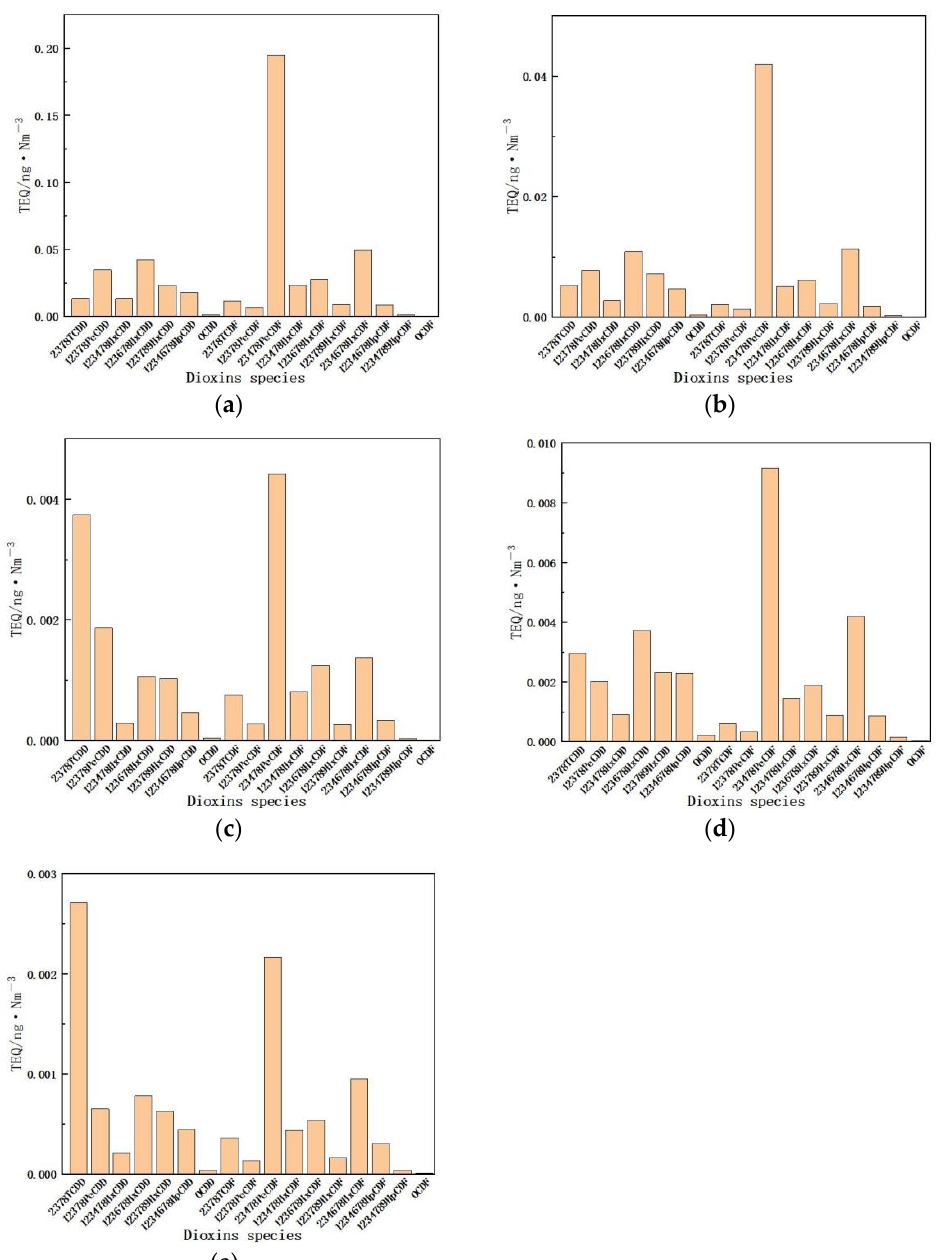
Figure 3. A total of 17 PCDD/Fs TEQ in fly ash: first baghouse without activated carbon injection, first baghouse with activated carbon injection and second baghouse with activated carbon injection. Based on the analysis of dioxins in fly ash, sampling and analysis of dioxins in gas samples were carried out at five points: inlet of the first baghouse, inlet and outlet of the second baghouse with and without activated carbon injection. The results are shown in Figure 4. bag system.